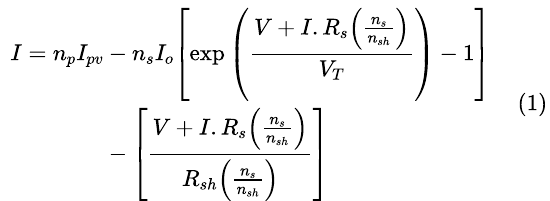
where and are the PV panel output current and voltage respectively. is the PV current; is the reverse satura- tion current; is the number of PV cell connected in series, and is the number of the PV cell connected in paral- lel. While describes resistance in series connection, and describes the resistance in parallel